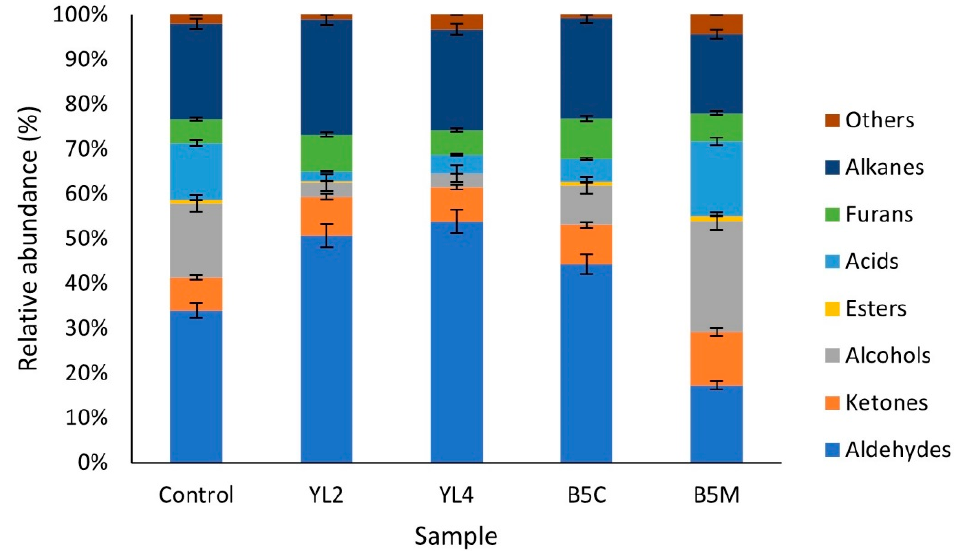
Figure 4. Classes of compounds detected and identified in the samples of fish waste incubated with the selected microorganisms. YL4 and YL2 ( Y. lipolytica ), B5C ( B. subtilis ) and B5M ( B. amyloliquefaciens ). Results are expressed as relative abundance (%). Control: fish waste without any microorgan- isms.